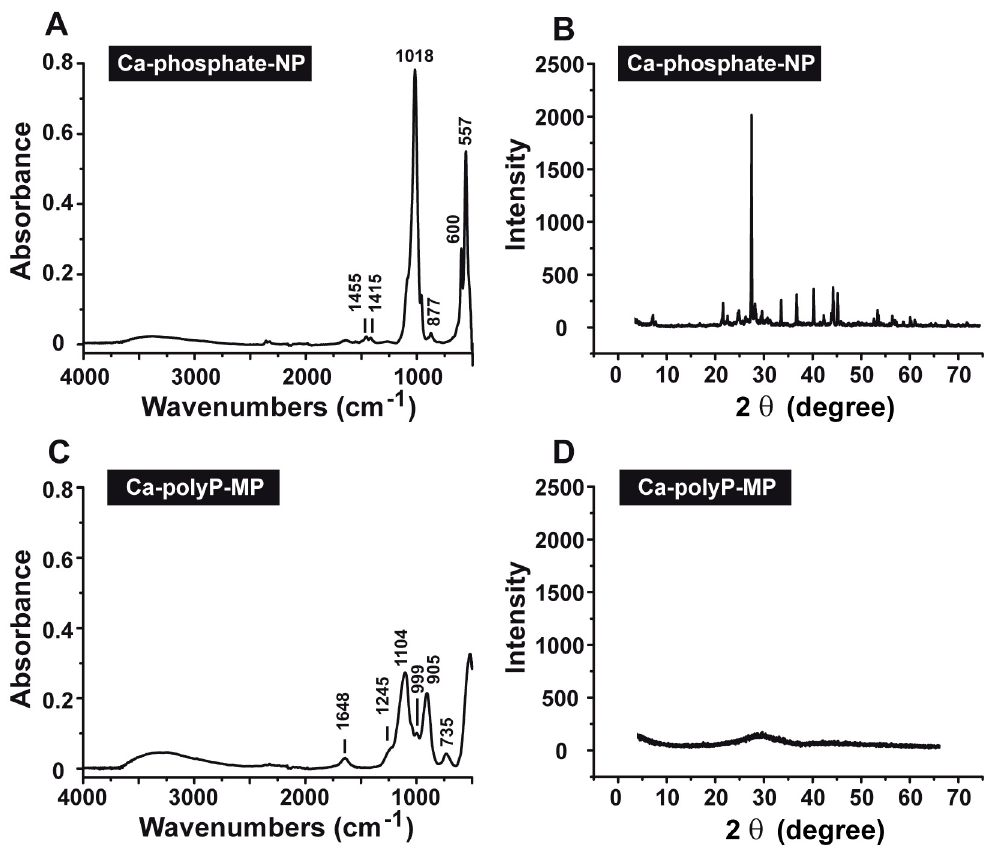
Figure 2. Characterization of the ( A , B ) Ca-phosphate-NP and ( C , D ) Ca-polyP-MP particles. The analyses were performed by ( A , C ) Fourier Transform Infrared (FTIR) and ( B , D ) X-Ray Diffraction (XRD).